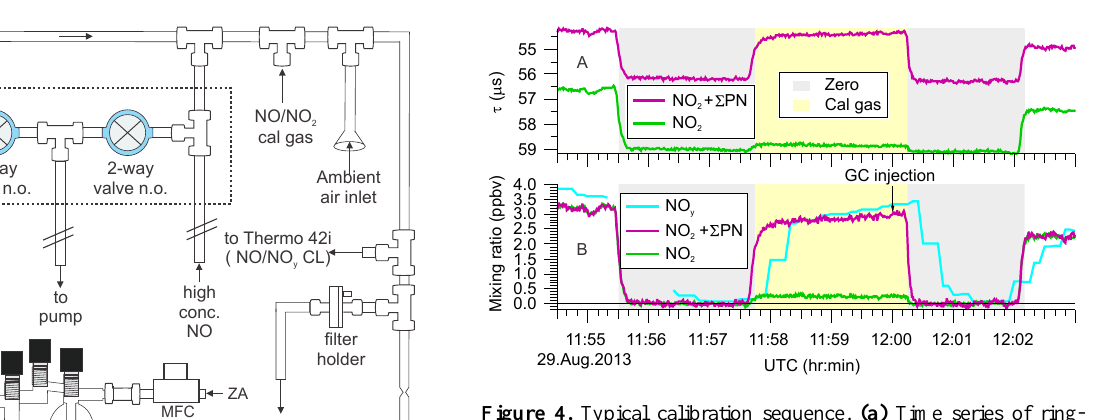
Figure 4. Typical calibration sequence. (a) Time series of ring- down time constants. (b) Time series of TD-CRDS and NO y mixing ratios. The instruments were “zeroed” at ∼ 11:55:30UTC. PPN was added at ∼ 11:57:40UTC. The GC was injected at noon (the chro- matogram is shown in Fig. 5b). Immediately after the injection, the instruments were zeroed again. The NO y signal was not adjusted for its slow response to concentration changes in this